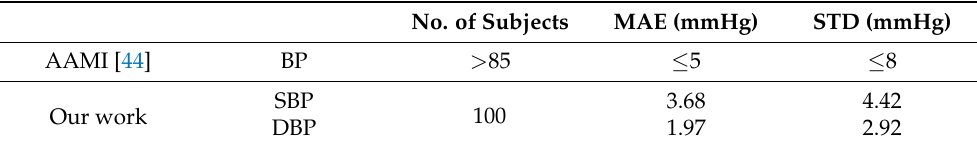
Table 3. Comparison of our result with the Association for the Advancement of Medical Instrumen- tation (AAMI) standard.